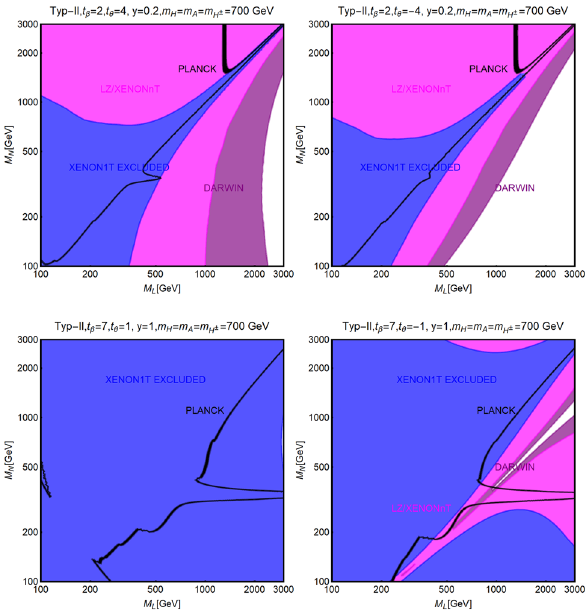
Fig. 5 The same as Fig. 4 but for Type-II model (abbreviated Typ-II) and different parameter assignations excluded region (blue) by current limits from Direct Detec- tion, essentially determined by XENON1T [110], as well as the projected sensitivities from XENONnT/LZ [113,114] (magenta, given the similar sensitivity we are assuming the same projected excluded region for both experiments) and DARWIN [115]